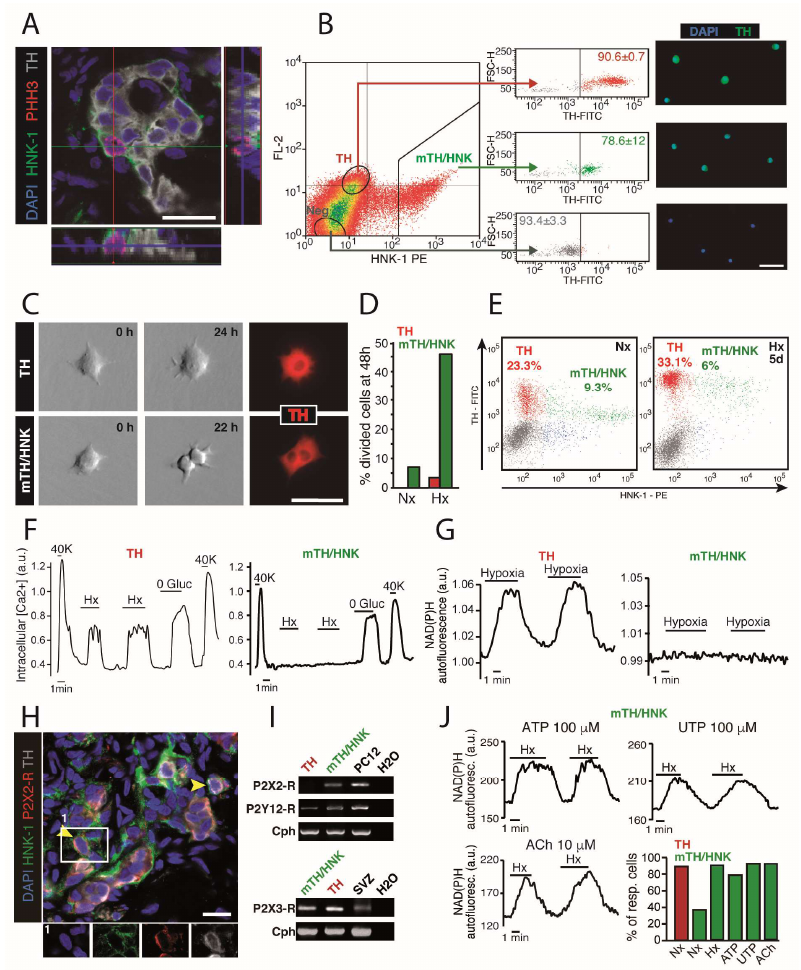
Figure 5. Carotid body neuroblasts. ( A ) Immunohistochemical analysis of CB from rats exposed to hypoxia for 48 h, illustrating the membrane expression of the glycoepitope HNK-1 in PHH3-positive proliferating CB neuronal (TH-positive) cells. Scale bar, 20 µ m. ( B ) Left, FACS plot representing HNK-1 staining versus FL-2 channel autofluorescence, with sorting gates to enrich mature (TH; which are HNK-1-negative and autofluorescent) and immature (mTH/HNK; which are HNK-1-positive) CB glomus cells. Middle, TH expression in the different sorted cells, as revealed by intracellular staining of fixed cells, confirming the nature of different sorted populations. The percentages inside the plots refer to the proportion of cells within that particular side of the plot with regard to TH expression ( n = 3 independent experiments with a total of 11 rats). Right, microscopy images of the different sorted cells, confirming their differential expression of the neuronal marker TH. Scale bar, 25 µm. ( C ) Time-lapse video microscopy imaging of TH-positive and mTH-positive/HNK-1-positive CB cells, sorted alive by flow cytometry (see B ). After 48 h recording, most cell division activity was observed in the HNK-1-positive subpopulation. Scale bar, 25 µm. ( D ) Quantification of cell divisions observed after 48 h using time-lapse microscopy, confirming that proliferation is a feature of HNK-1-positive CB neuronal cells ( n = 42 TH-positive and 42 mTH-positive/HNK-1-positive cells exposed to normoxia (Nx; n = 3 rats), and 96 TH-positive and 89 TH-positive/HNK-1-positive cells exposed to hypoxia (Hx; n = 5 rats)). Data in bar graph are represented as the sum of dividing cells among total cells studied. ( E ) Flow cytometry analysis of dispersed CB cells from normoxic (Nx) and 5 days hypoxic (Hx) rats, stained for TH and HNK-1. Note how mTH/HNK cells convert into TH (HNK-1-negative) mature glomus cells upon exposure to hypoxia. ( F ) Increases in intracellular calcium concentration in response to different stimuli, measured by changes in the fluorescence of the calcium indicator FURA-